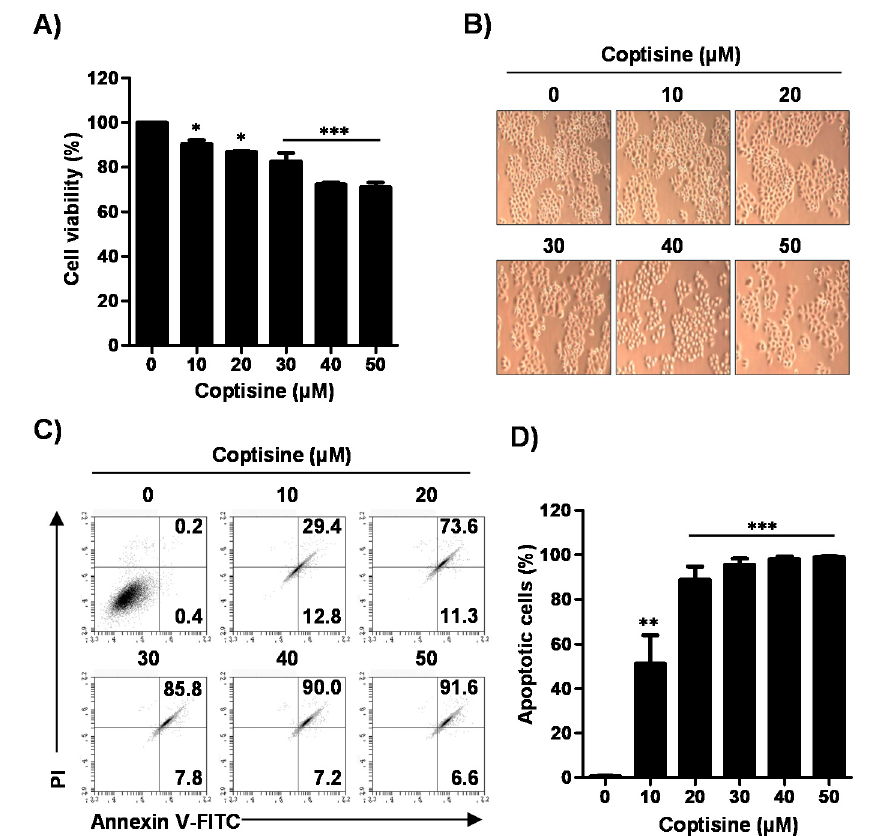
Figure 1. Effects of coptisine on cell viability and apoptosis in Hep3B cells. Hep3B cells were treated with the indicated concentrations of coptisine for 24 h. ( A ) After treated with coptisine, added the a 3-(4,5-dimethylthiazol-2-yl)-2-,5-diphenyltetrazolium bromide (MTT) solution, reacted for 2 h and then detected cell viability; ( B ) The morphology of Hep3B cells by coptisine were observed by phase-contrast microscopy (magnification, × 50); ( C ) The cells were harvested and stained with annexin V-fluorescein isothiocyanate (FITC) and propidium iodide (PI). After staining, cells were analyzed the apoptosis by flow cytometry. Annectin V-FITC results represent early apoptosis (lower right quadrant), and late apoptosis (upper right quadrant); ( D ) Statistical analysis of annexin V positive cells (** p < 0.01, and *** p < 0.001 vs. control). The results are presented as the mean ± standard deviation (SD) of three independent experiments.